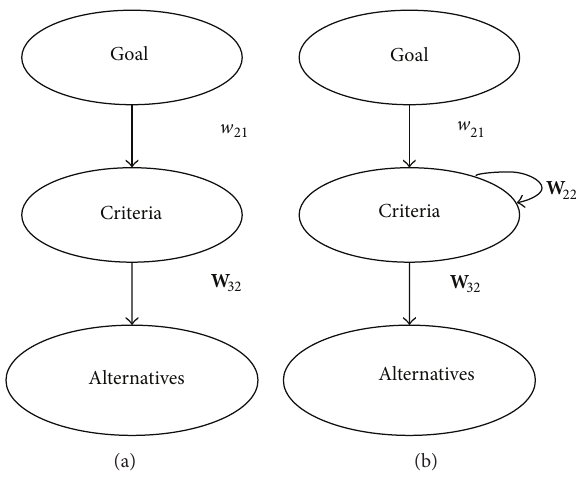
Figure 5: Hierarchy and network: (a) a hierarchy; (b) a network.